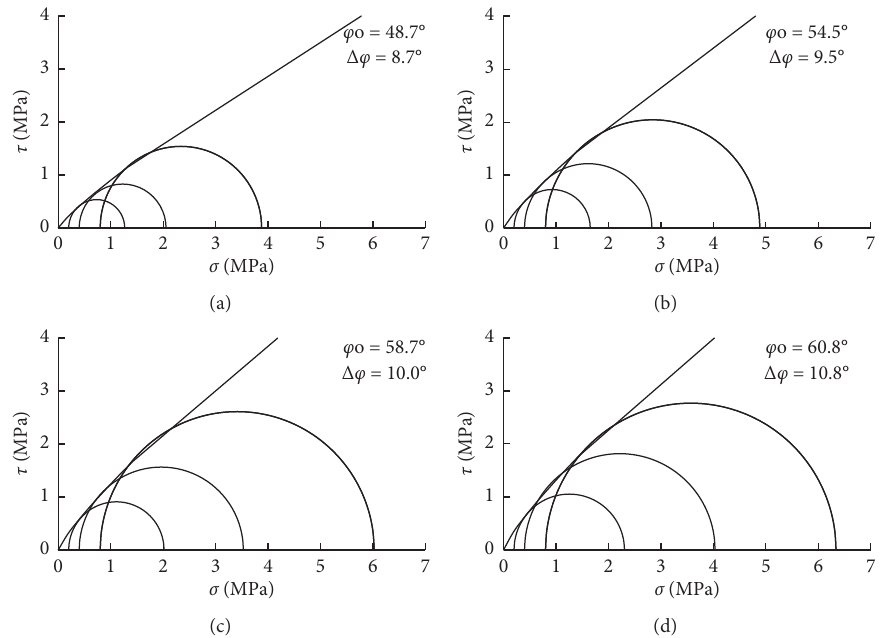
Figure 14: Nonlinear strength envelopes of the coarse granular material at different b values: (a) b � 0.0; (b) b � 0.25; (c) b � 0.50; (d) b � 0.75.